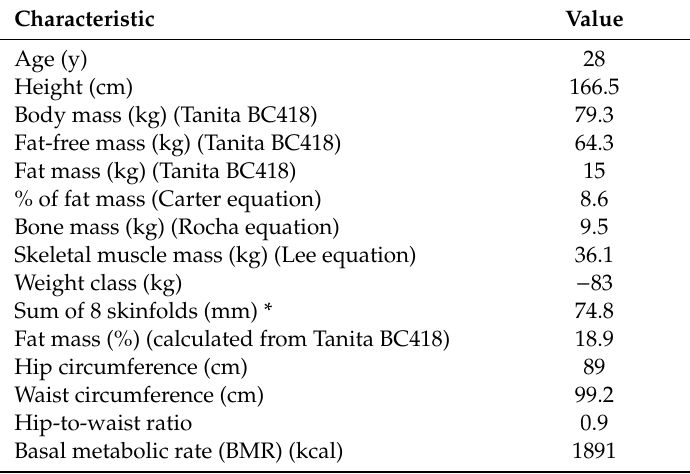
Table 2. Anthropometric characteristics at baseline.